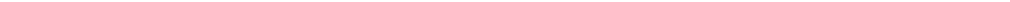
Fig. 9a-n. Example of how components lasting more than 8 h and concerning the signals recorded by TRC sta- tion on the 18th April 2002 are filtered. In (a), (b) and (c) the two tiltmeter signals and the termic one, acquired every 10 s, are shown respectively, while in (d), (e) and (f), the signals undergo a 1 h moving average procedure, which allows us to reduce noise. In (l), (m) and (n) the Inverse Fast Fourier Transform (IFFT) of the smoothed signals are computed, highlighting only harmonic content having a period of time lasting more than 8 h. In (g), (h) and (i) harmonic having a period of time lasting less than 8 h are shown: a) NS signal, d) smoothed data, g) high pass data, l) low pass data; b) EW signal, e) smoothed data, h) high pass data, m) low pass data; c) Te sig- nal, f) smoothed data, i) high pass data and (n) low pass data. Fig. 10a,b. Tilt variations induced by an earthquake with epicentral distance of 1.2°. In this figure, 20 min (120 data points) of the NS (a) and EW (b) signals recorded at TRC station are shown. The followings numbers close to the peaks point out the main variations of the signals: 50th acquisition at 20:56:56 UTC; 51th at 20:57:06 UTC; 52th at 20:57:16 UTC; 53th at 20:57:26 UTC; 55th at 20:57:46 UTC; 56th at 20:57:56 UTC; 60th at 20:58:36